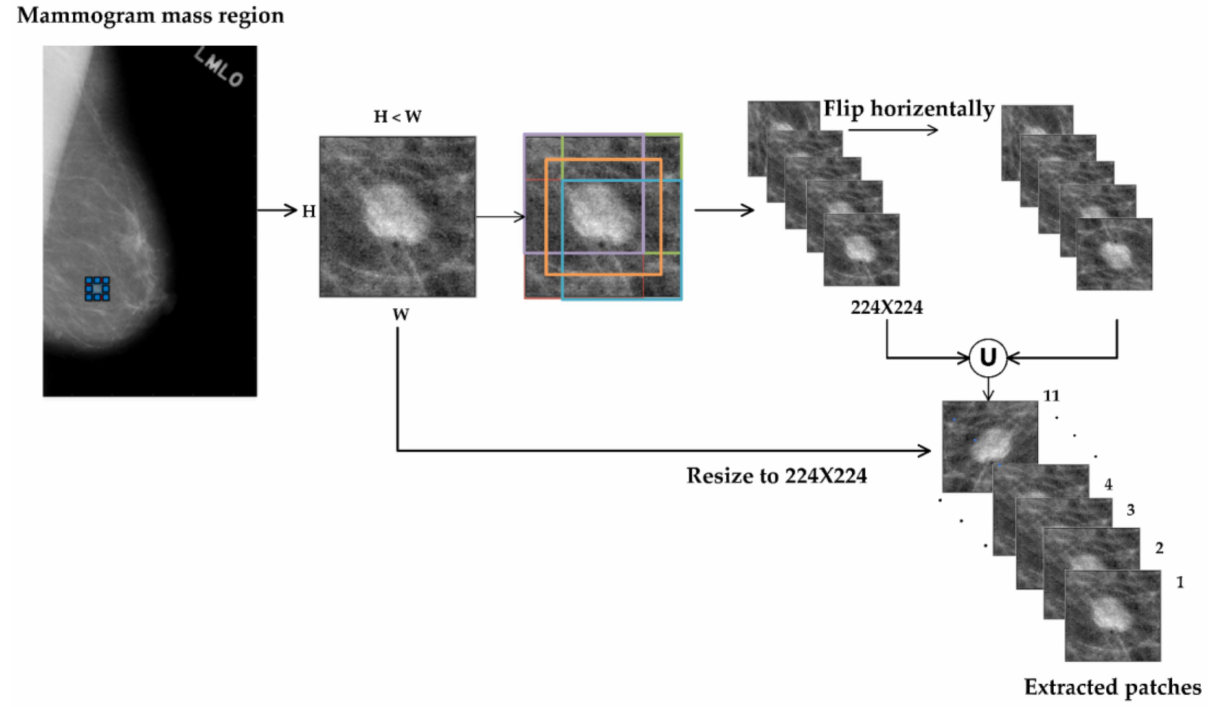
Figure 3. The ROIs with different contextual information, modeled using translation-based technique.